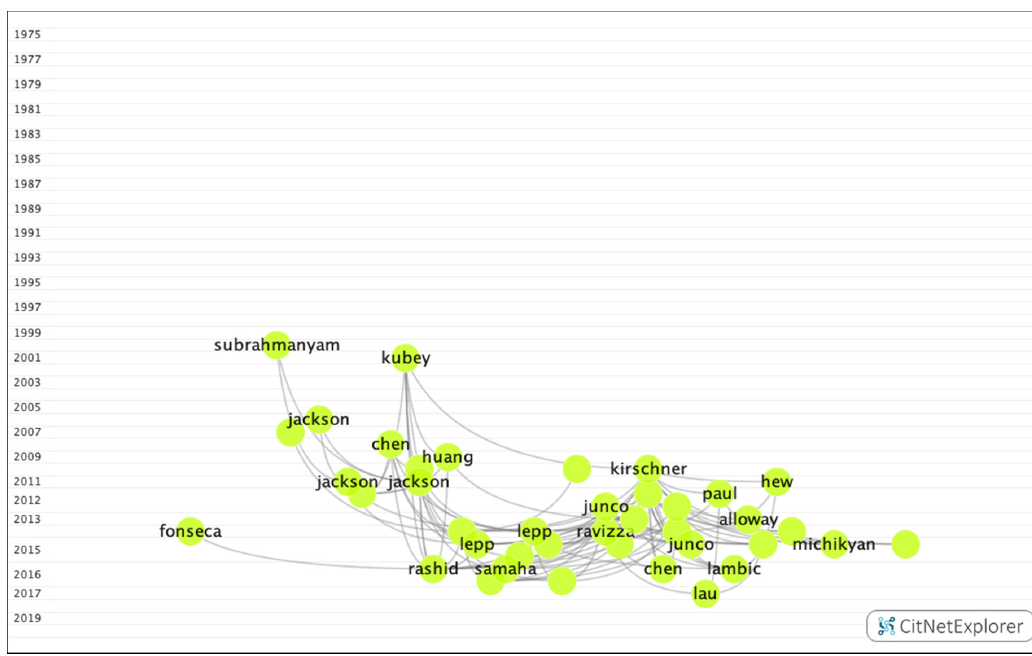
Figure 15. Group 9 citation network.